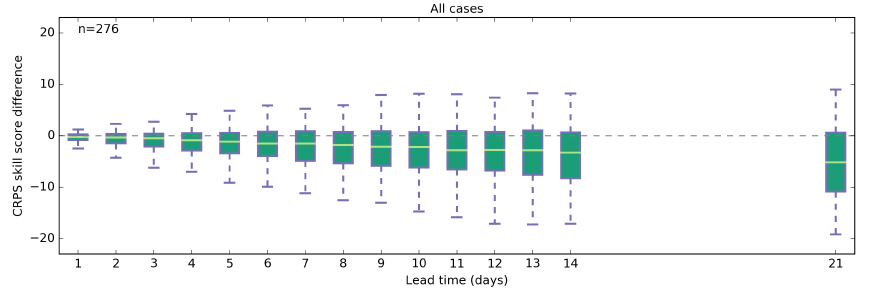
Figure 8. Box plots of CRPS skill score differences between forecasts at 1–21-day lead time and lead time 0. The boxes capture the median and the [0.25, 0.75] and [0.05, 0.95] quantile ranges. For each lead time, the CRPS skill score differences for every forecast location and season have been pooled. n is the number of cases per box plot (23 locations × 12 seasons = 276 cases).